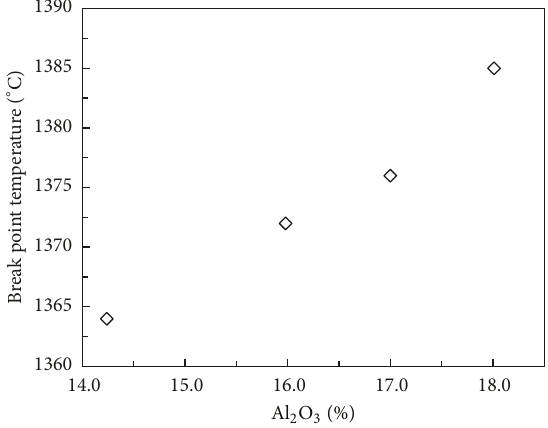
Figure 4: Break point temperature for slag series A and basic